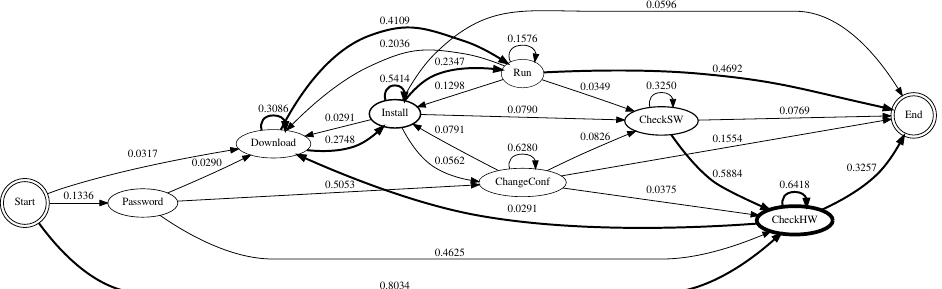
Figure 7. State diagram of the attacker’s behaviour on Cowrie.